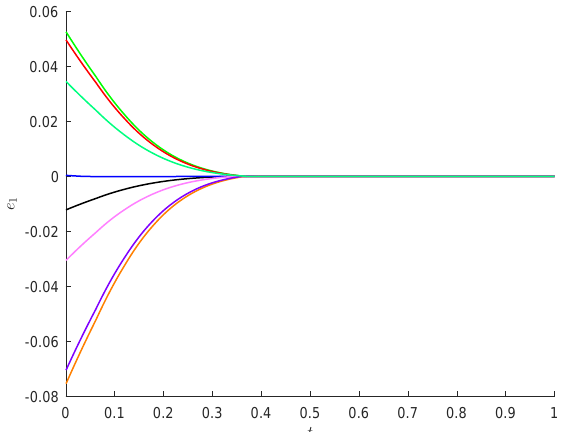
Figure 4. State trajectories of the error e 1 in Example 2, for 8 initial values (depicted with different colors). Best viewed in